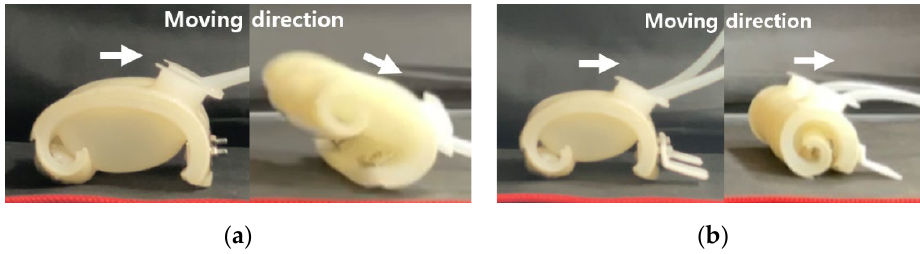
Figure 15. Comparing landing motion for mounting front foot; ( a ) Landing motion before mounting front foot. ( b ) landing motion after mounting front foot type.